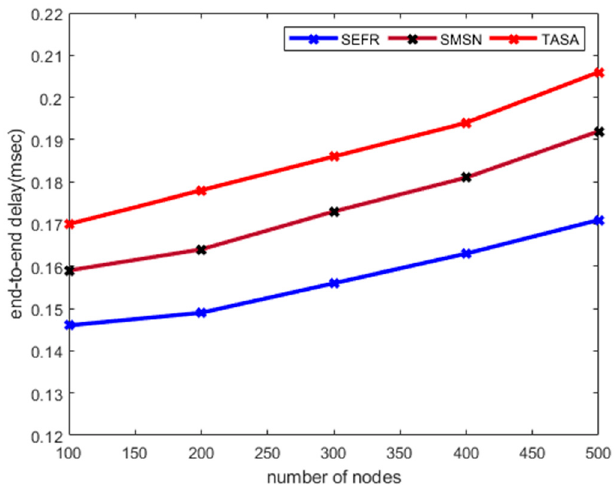
Figure 4. End-to-end delay with varying number of nodes.